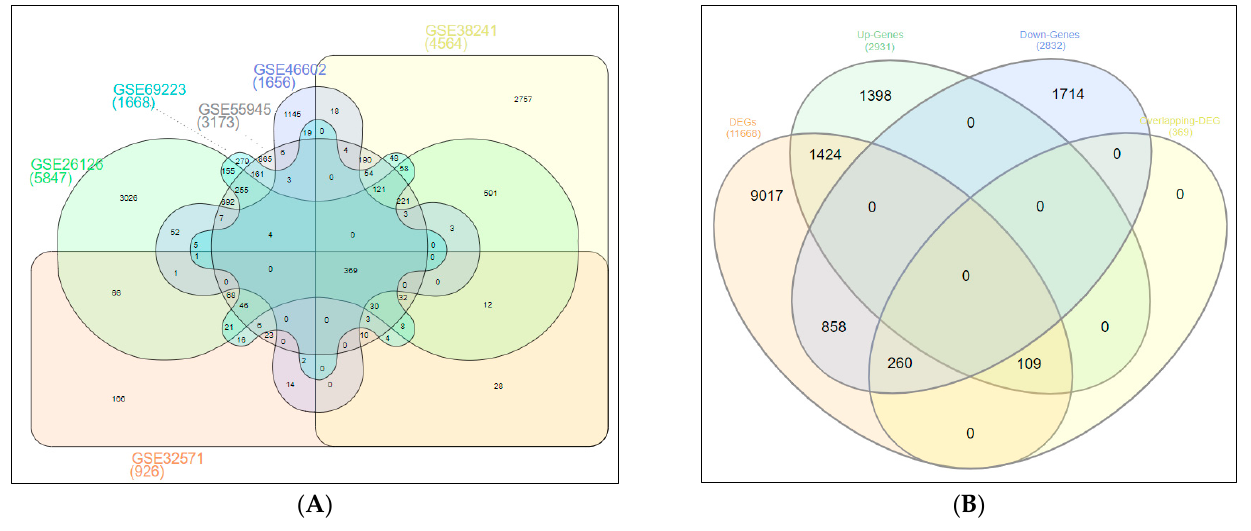
Figure 2. Venn diagram of the: ( A ) overlapping DEGs from six GEO microarray datasets for PCa, 369 DEGs were identified among the six GEO microarray datasets; and ( B ) DEGs (11668), up-regulated genes (2931), down-regulated genes (2832), and overlapping DEGs (369) from GEO microarray datasets for PCa. Overlapping up-regulated (109) and down-regulated (260) DEGs were identified. Color code. Table 2. UCSC_TFBS enrichment analysis showed TFs that bind to the subsets of the genes by the protein interactions option of the functional annotation tool of 260 down-regulated overlapping genes in